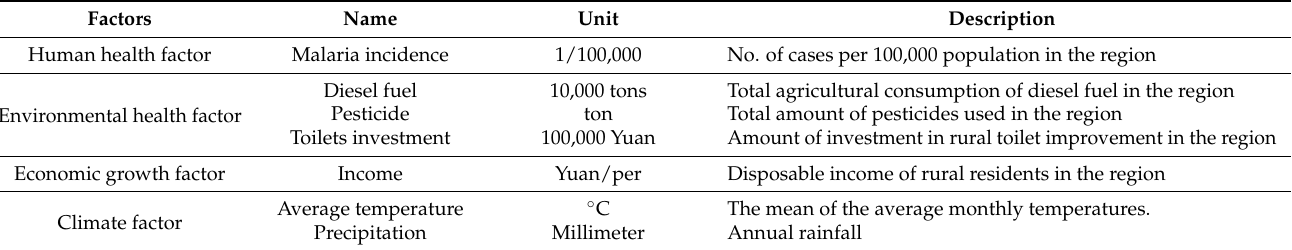
Table 1. One Health factors and